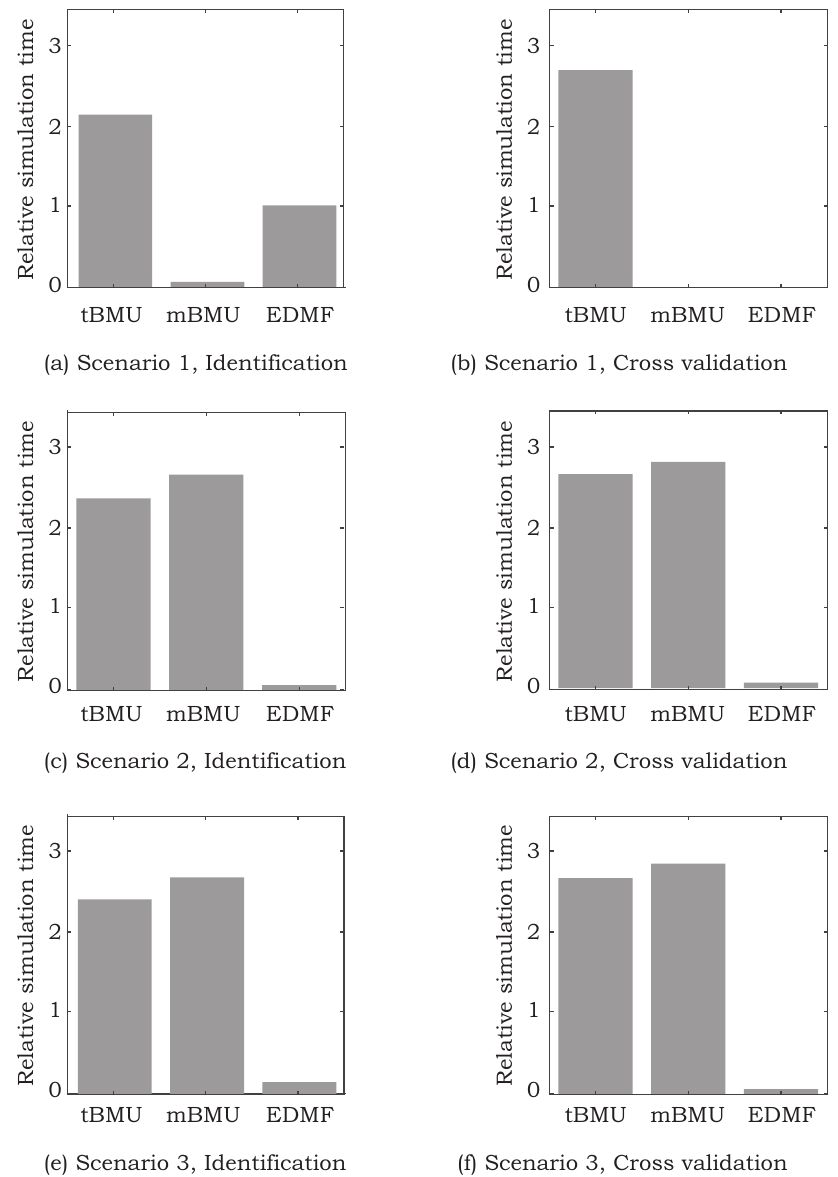
Figure 13. Comparison of computation times for the three probabilistic data-interpretation methodologies. Computation time is for parallel computing using up to 24 cores and is presented in relative time with respect to simulation time for EDMF in Scenario 1